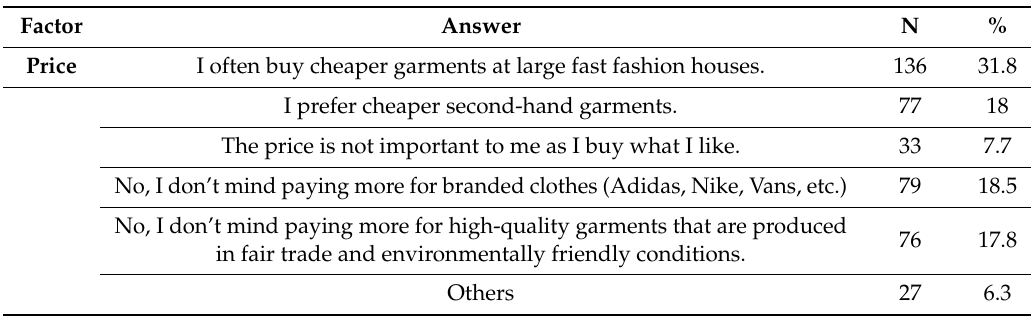
Table 4. The price as a decisive